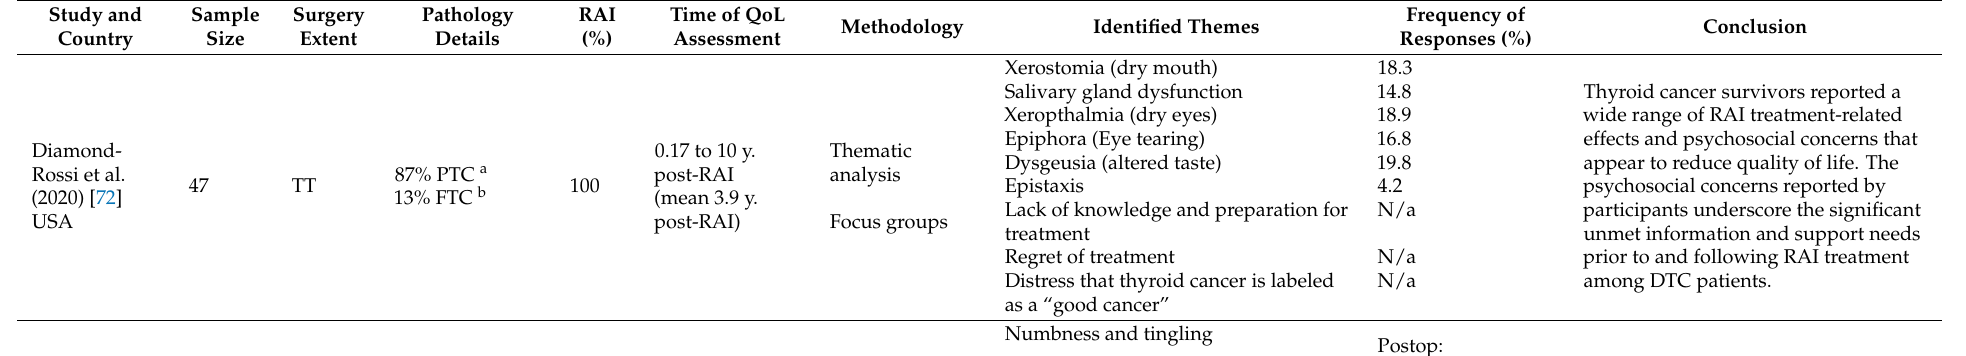
Table 6. HrQoL outcomes after thyroid surgery for qualitative and mixed-methods